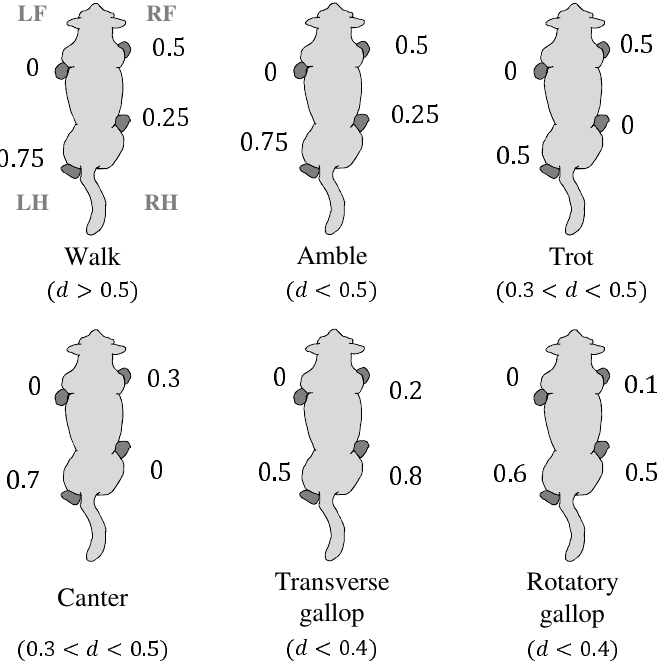
Figure 6. Ground contact sequences with respect to gait phases; LF, LH, RF, and RH refer to the left-front, the left-hind, the right-front, and the right-hind, and d means the continuous ground contact time ratio of one gait cycle